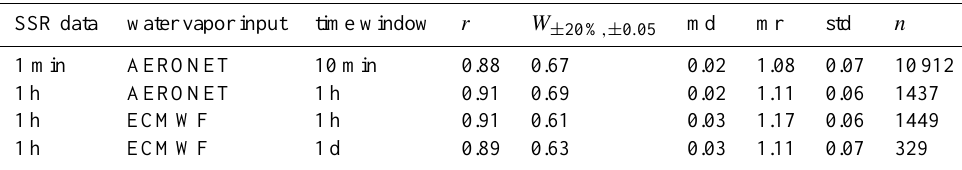
Fig. 2. Scatter plot of AERONET aerosol optical depth at 500nm (AOD 500 ) versus pyranometer-based effective aerosol optical depth (AOD eff ) using (left) one minute values of the surface solar radiation (SSR) and AERONET water vapor column, and (right) hourly values of the measured SSR and ECMWF water vapor column. r is the correlation coefficient and n is the number of data pairs. Table 2. Performance of the method. SSR is surface solar radiation; r is the correlation coefficient; W ± 20% , ± 0 . 05 is the fraction of data found within either ± 20% or ± 0 . 05 of the reference value; md is the median difference; mr is the median ratio; std is the standard deviation of the ratio; and n is the total number of data